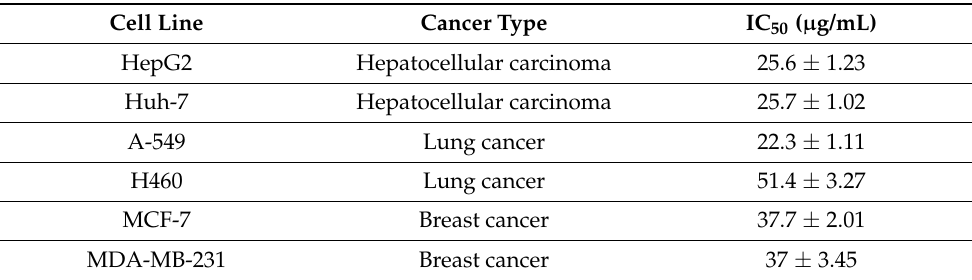
Table 2. IC 50 values (ug/mL) for the effect of Er-ZnONPs on different cancer cells representing different tumor types. Results are represented as mean value (M) ± S.E.M of at least three independent experiments (three replicates each).